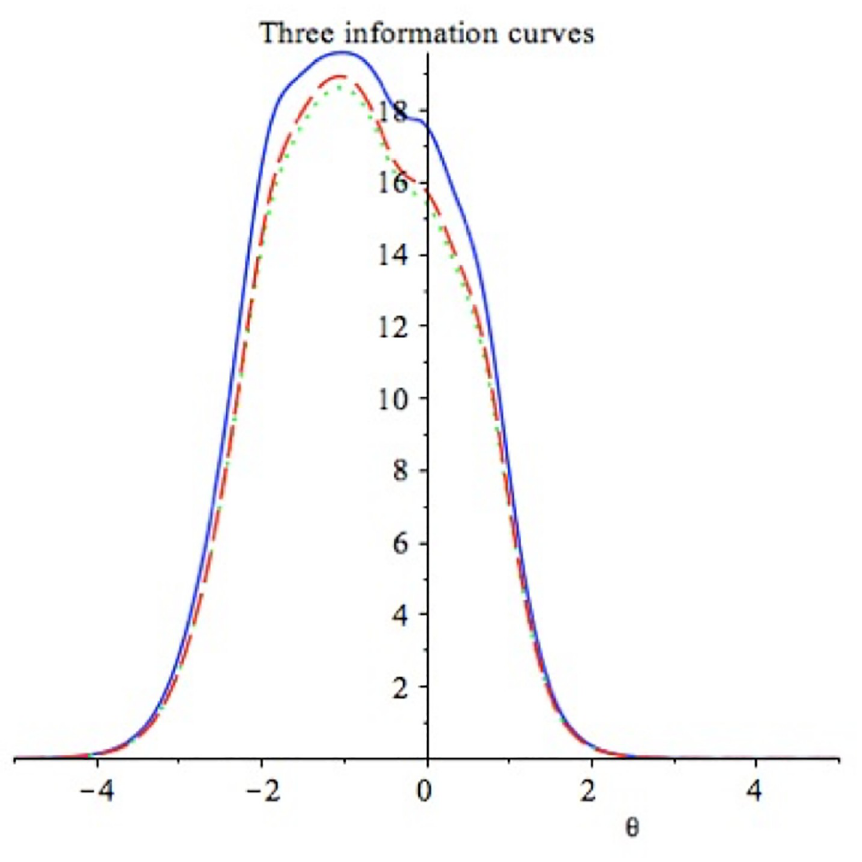
Fig 3. Study 1 information function for the three candidate compositing rules. The solid line is the Maximum Likelihood estimated theoretical maximum information, the dashed line is the a the dotted line is the unit-weighted composite